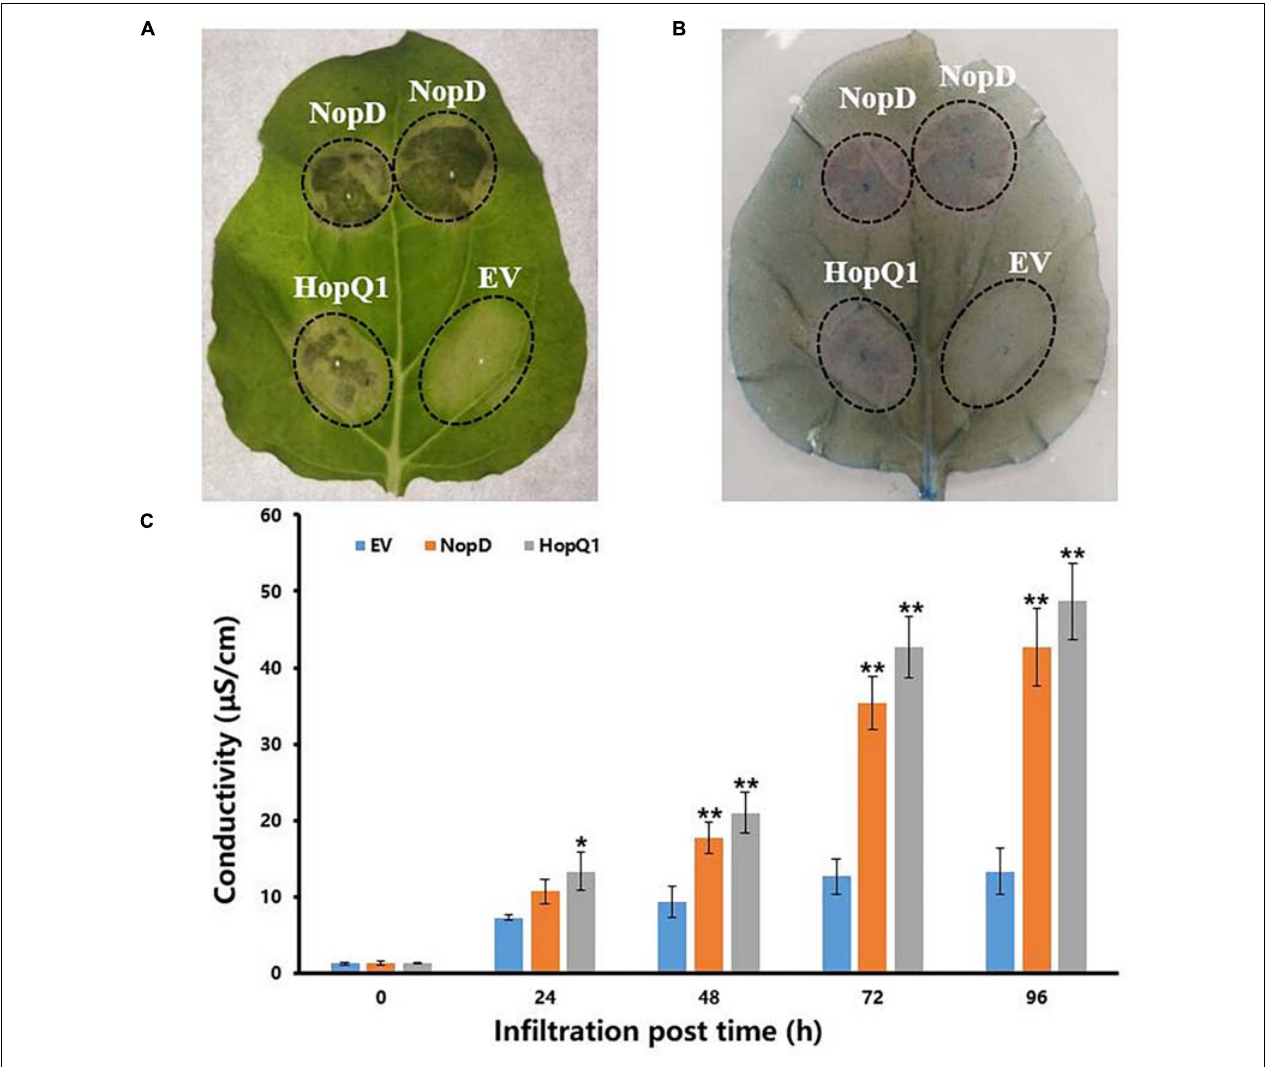
FIGURE 2 | Effects of NopD on N. benthamina cells. Infiltrated zones are marked by circles (EV, infiltration zone with A. tumefaciens carrying the empty vector pGWB17-T). For comparison, A. tumefaciens carrying plasmid pGWB17-HopQ1-myc was also used for infiltration (expression of HopQ1 of P. syringae pv. tomato DC3000). (A) Leaves were photographed 4 days post infiltration. (B) Trypan blue-based cell death staining of a representative N. benthamiana leaf transiently expressing NopD and HopQ1 4 days post Agrobacterium infiltration . (C) Electrolyte leakage levels in leaves. “*” indicated the significant differences ( p ≤ 0.05) and “**” indicated the significant differences ( p ≤ 0.01).